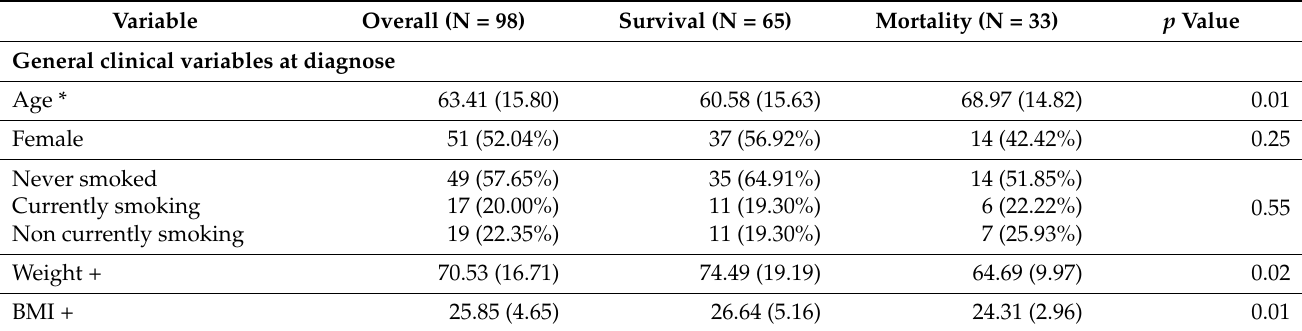
Table 2. Biochemical, clinical and body composition variables and their correlations with survival and overall